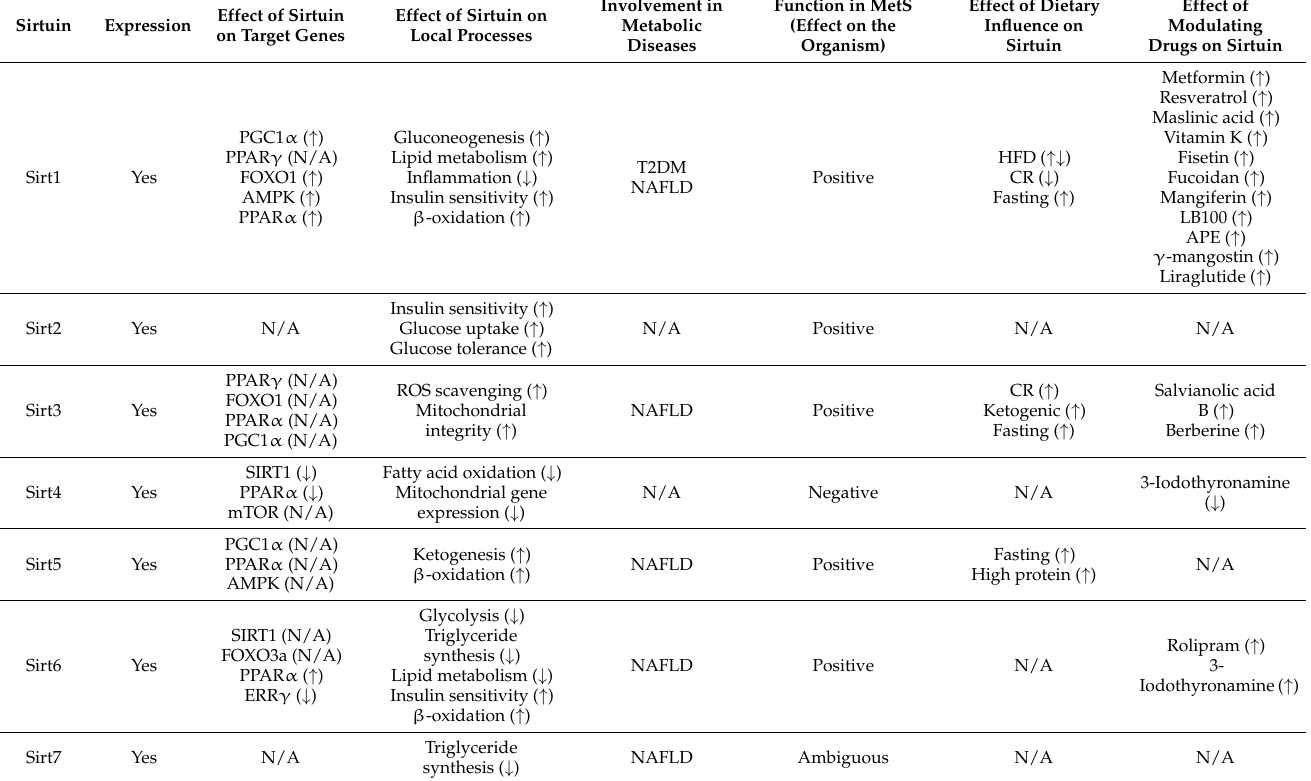
Table 2. Overview of the role of Sirtuins in the